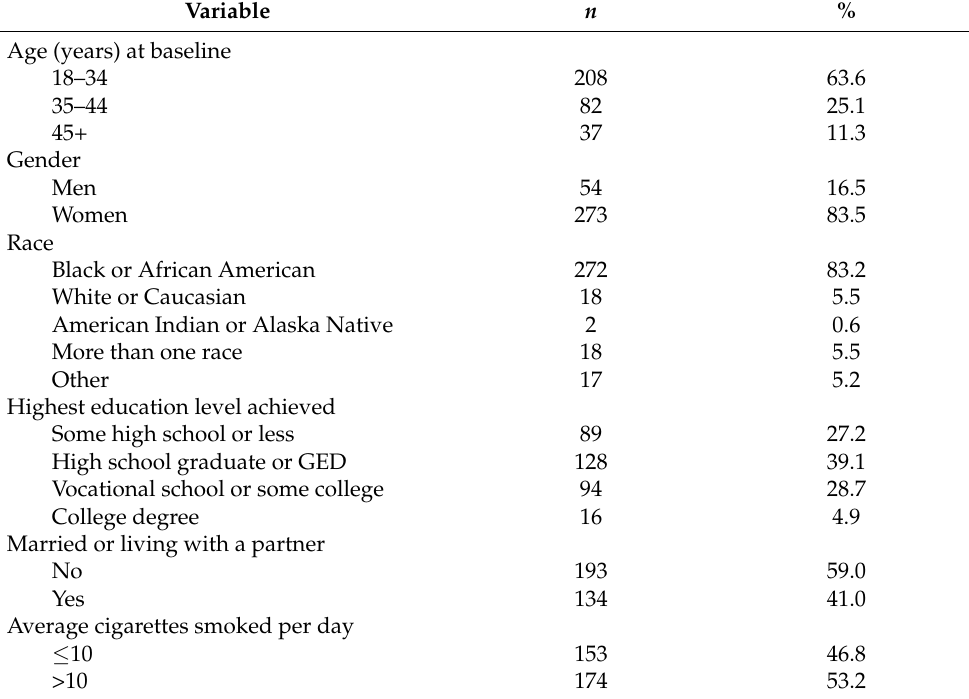
Table 2. Demographic and smoking characteristics of participants at baseline ( n =